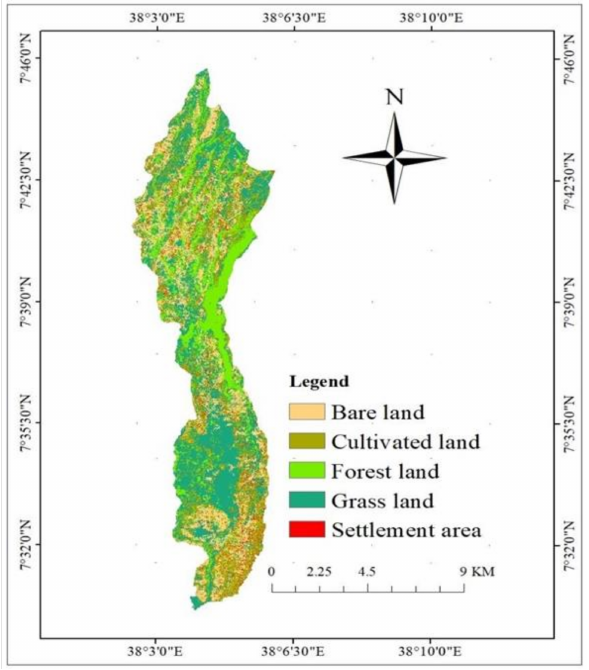
Figure 6. The LULC Map of Matenchose watershed in 1991.